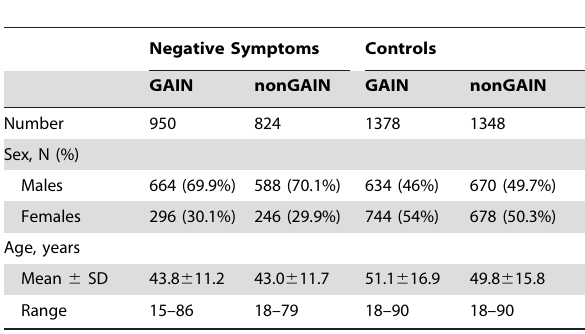
Table 1. Descriptive Characteristics of Negative Symptoms of SCZ and